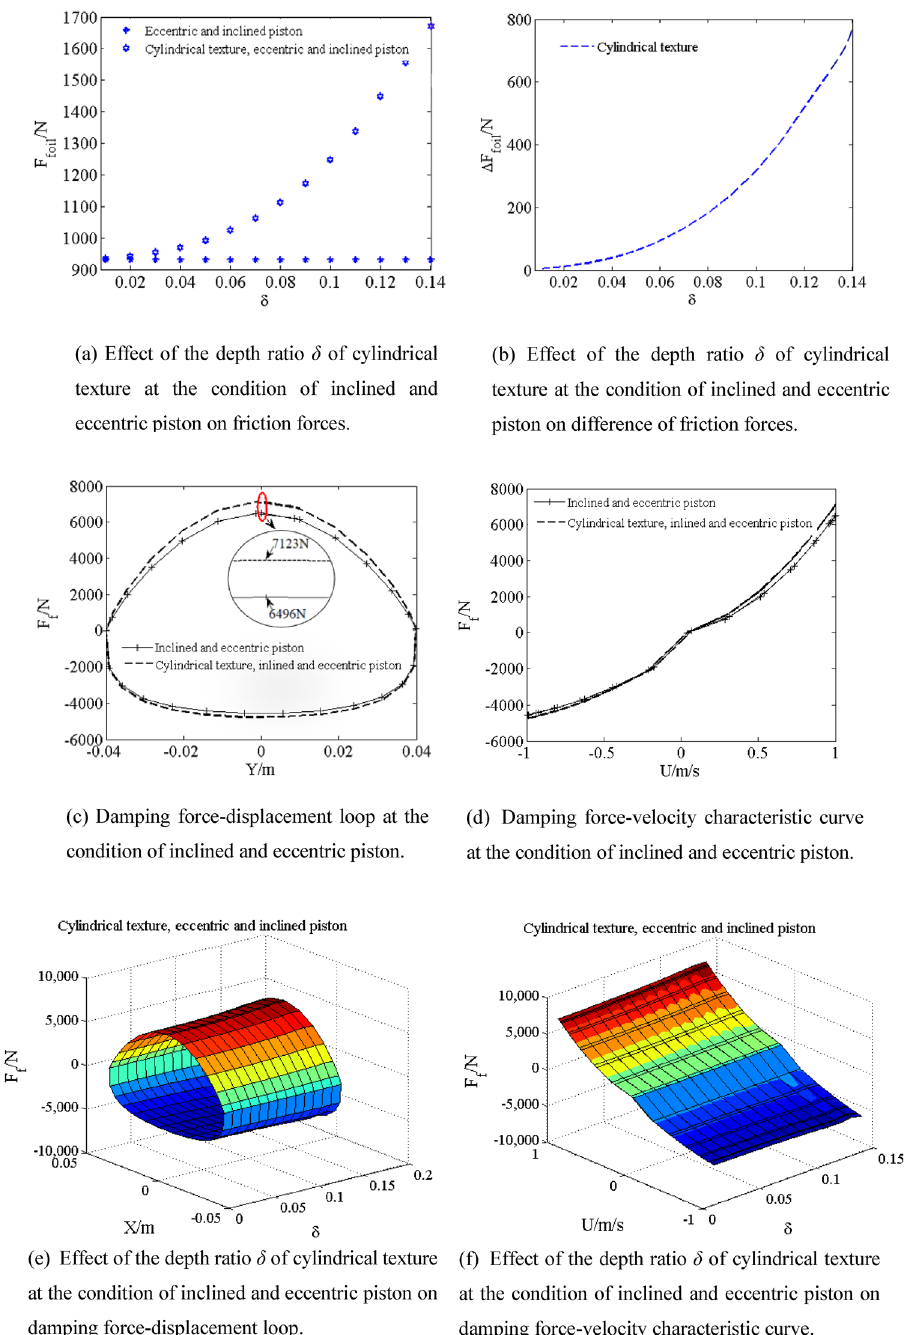
Figure 11. Effect of the depth ratio δ of cylindrical texture at the condition of inclined and eccentric piston on damping